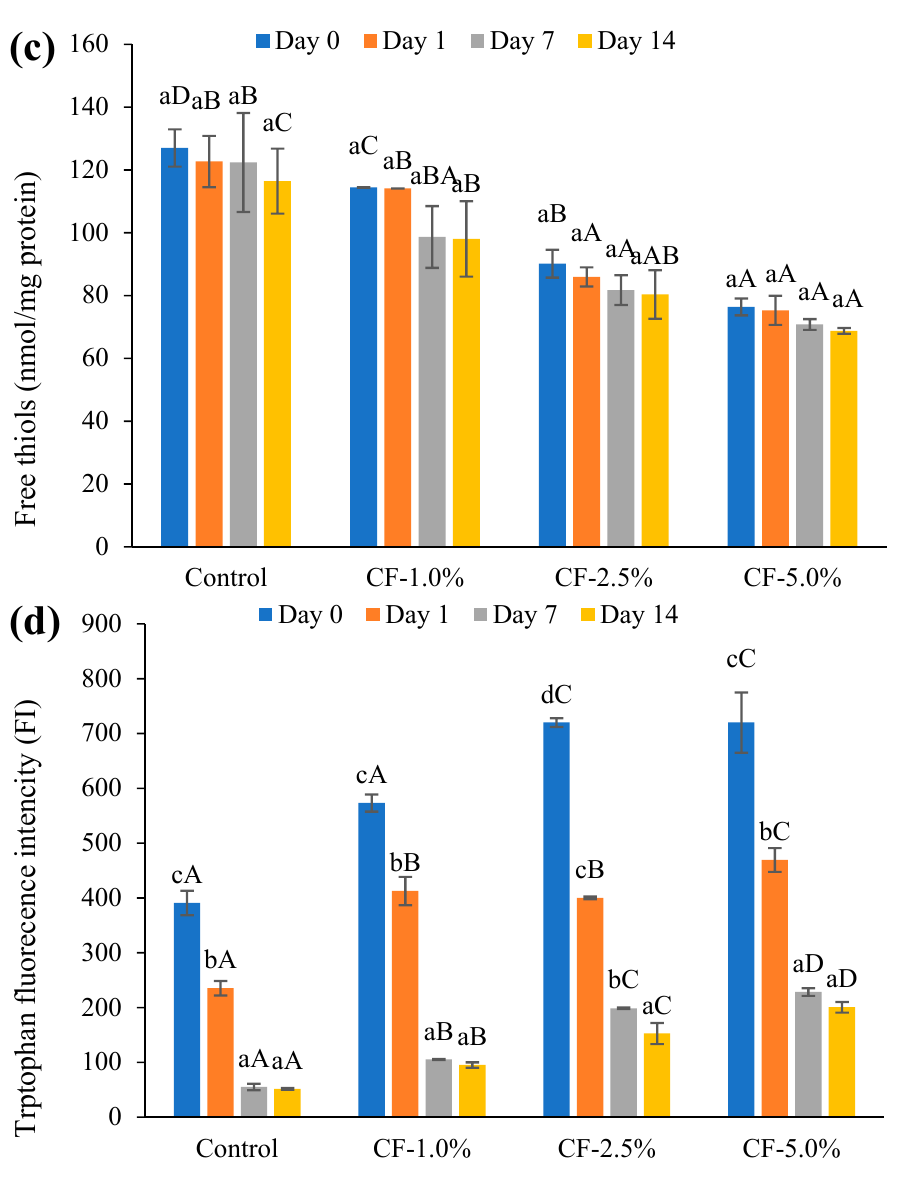
Figure 3. Oxidation of lipids and proteins of the cooked sausages during 14 days of storage (dark, 4 ◦ C). ( a ) TBARS, ( b ) carbonyls, ( c ) free thiols, and ( d ) tryptophan fluorescence intensity. The control sample represents the sausage formulated with lean pork and pork fat. Control sausages are formulated with lean pork, pork fat, salt, phosphate, and ice water; CF sausages are hybrid sausages formulated by adding CF at 1% (CF-1.0%), 2.5% (CF-2.5%), and 5.0% (CF-5.0%) levels to the base (control) recipe. Significance differences ( p < 0.05) are denoted by lowercase letters for different days within each sausage group, and by capital letters for different sausage groups on each day.